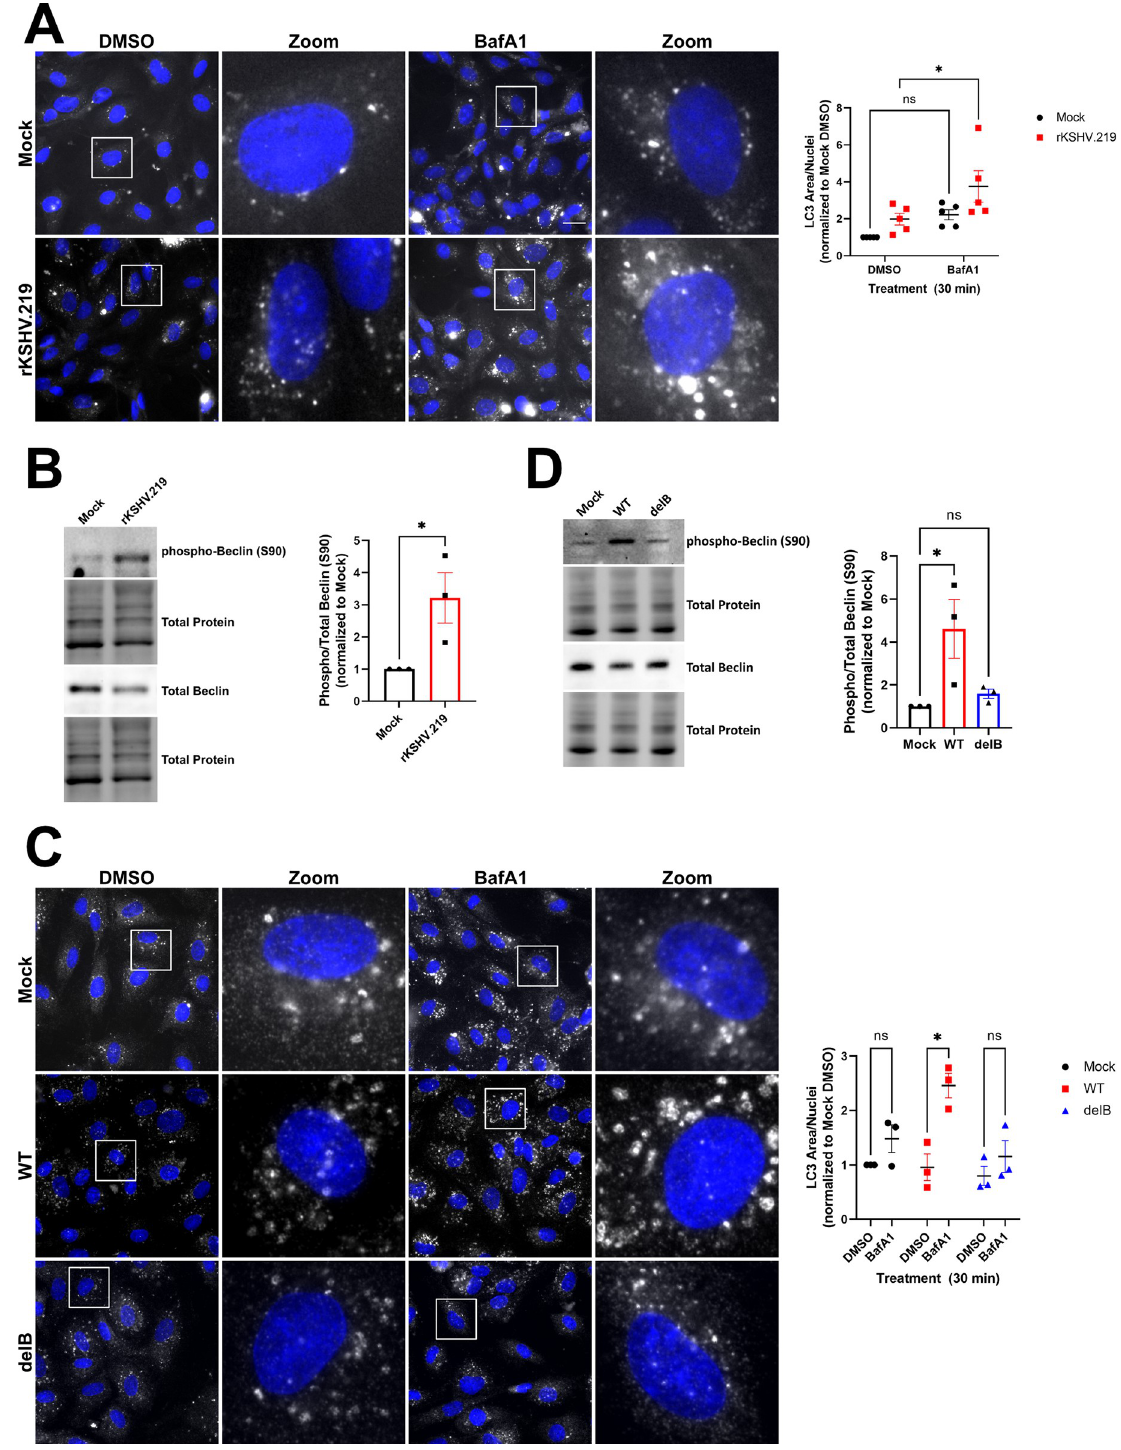
Fig 7. KSHV infection induces autophagic flux and phosphorylation of Beclin. A: HUVECs were infected with rKSHV.219 via spinoculation and infection was allowed to proceed for 96 h prior to treatment with Bafilomycin A1 (10 nM) for 30 min. Coverslips were fixed in methanol and immunostained for LC3 (autophagosomes; white), viral latency associated nuclear antigen (LANA, not shown), and DAPI (nuclei, blue). Scale bar = 20 μ m. Total LC3 area per field was quantified by identifying LC3 puncta using CellProfiler and normalizing to the number of nuclei and the Mock DMSO control. Results were plotted in GraphPad and a 2-way ANOVA was performed